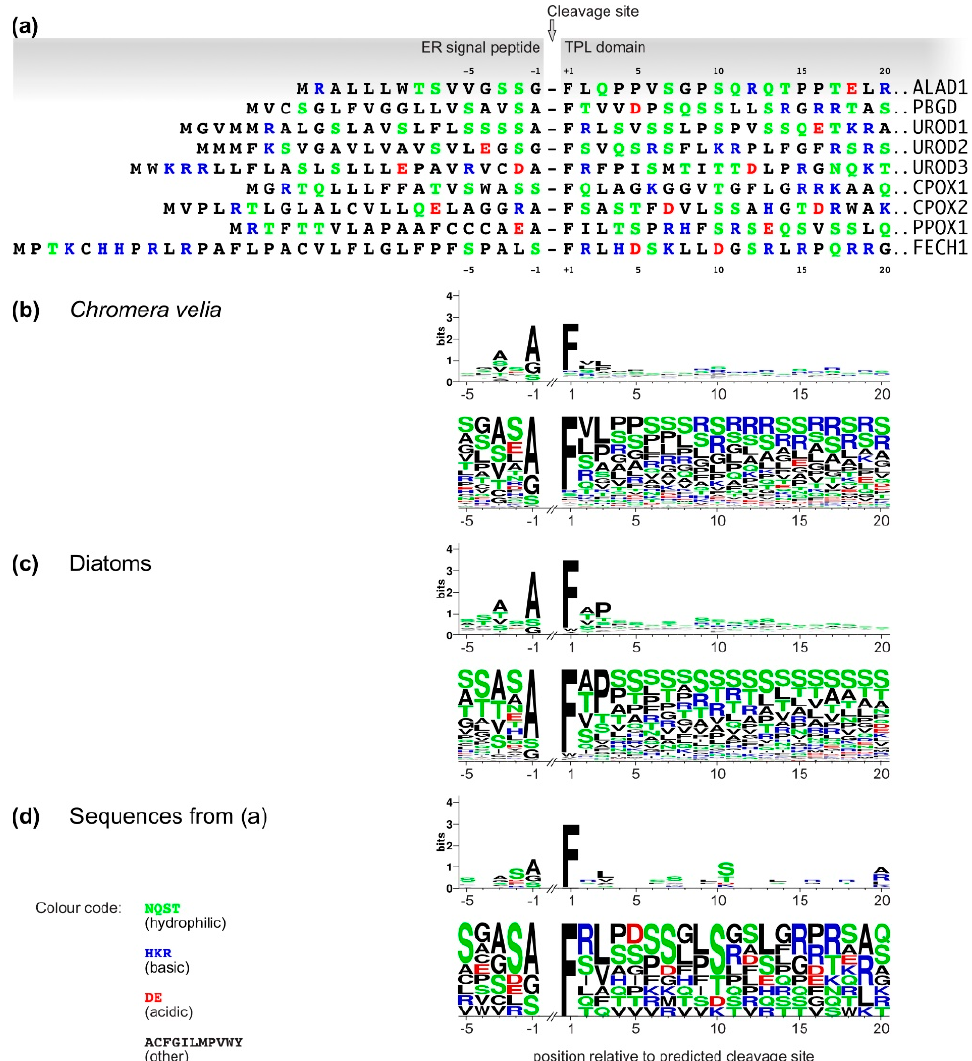
Figure 3. ( a ) ER-SP and TP domains of C. velia heme pathway enzymes. Coordinates are relative to the predicted SP cleavage site (arrow). Only enzymes that were positive for BTS are shown, amino acids in one letter code, color code is identical for all panels. ( b – d ) Sequence logos (upper panels) and frequency plots (lower panels) of plastid targeting BTS cleavage site motifs and TPs from ( b ) C. velia ( n = 146 data from [5]), ( c ) diatoms ( n = 166, reproduced from [53]), and ( d ) the C. velia heme pathway enzymes shown in A ( n = 9).